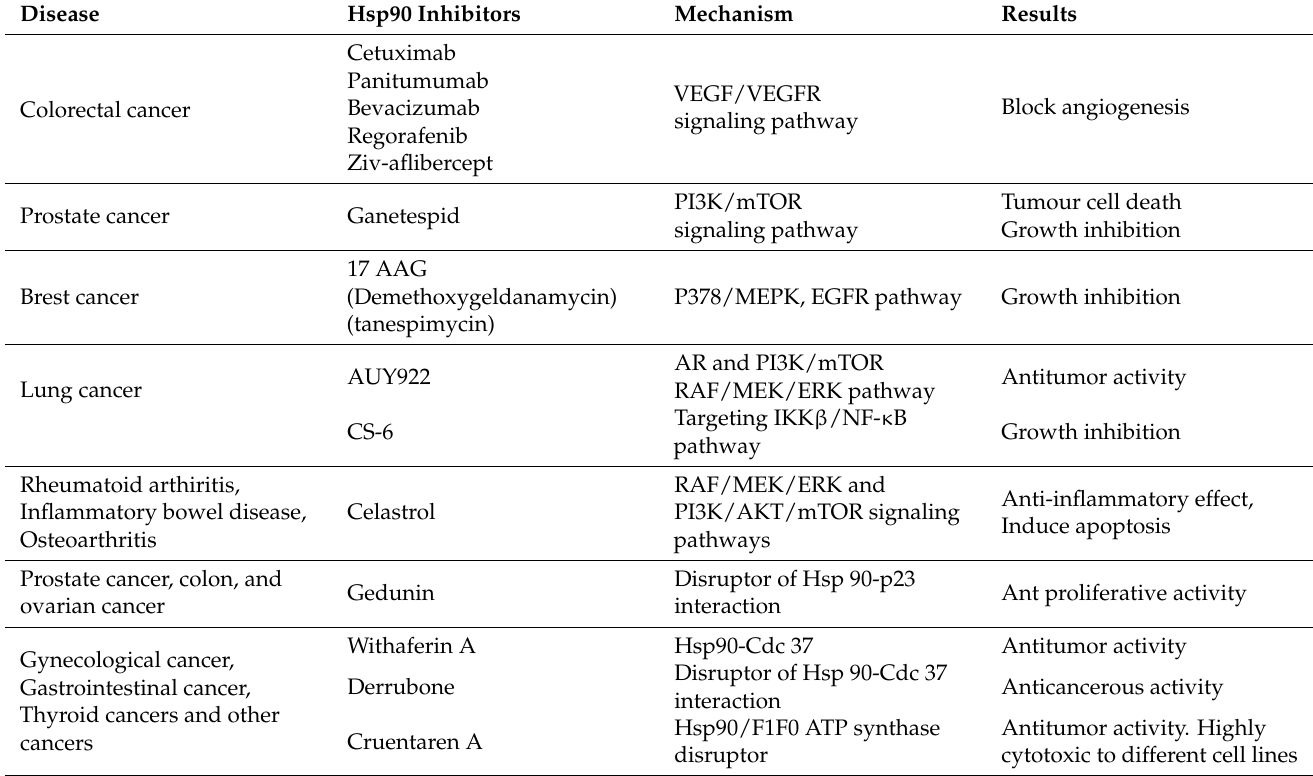
Table 1. List of various Hsp90 inhibitors used in different diseases which impact distinctive mecha- nistic